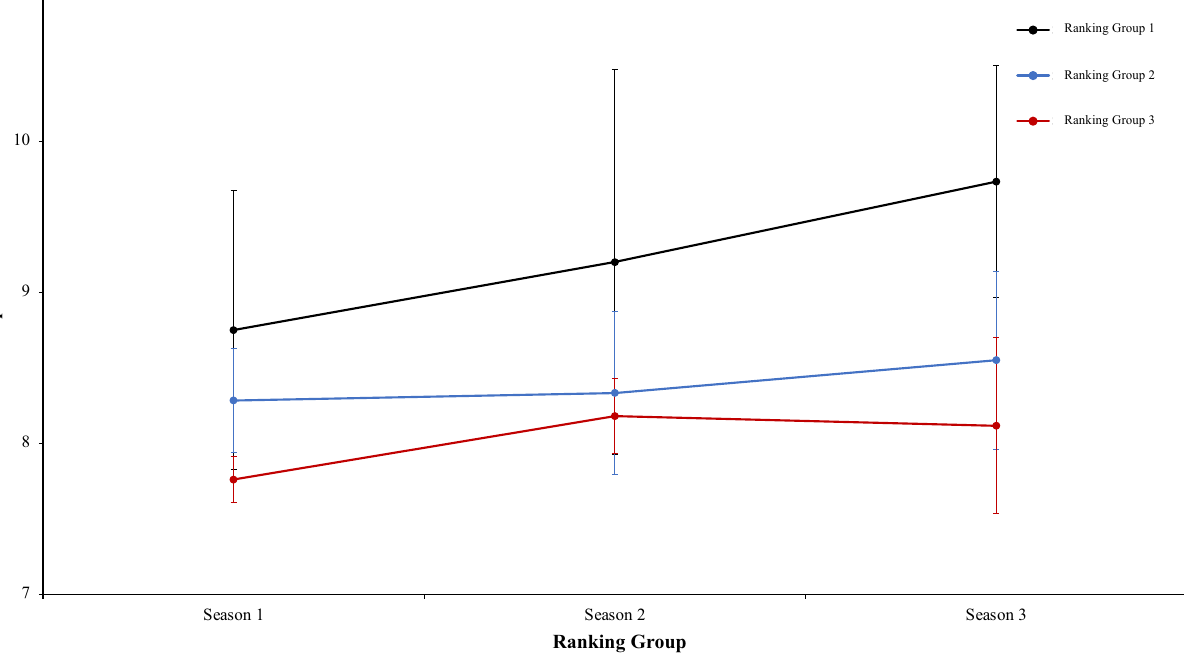
Figure 11. Technical performance. Mean correct pass per minute (± SE) as a funtion of Ranking and Season Condition.